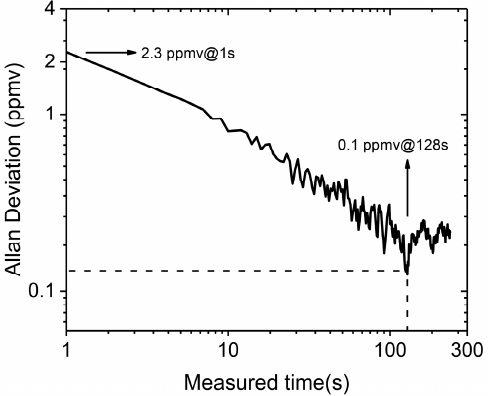
Figure 5. Allan deviation from the time-series measurement.